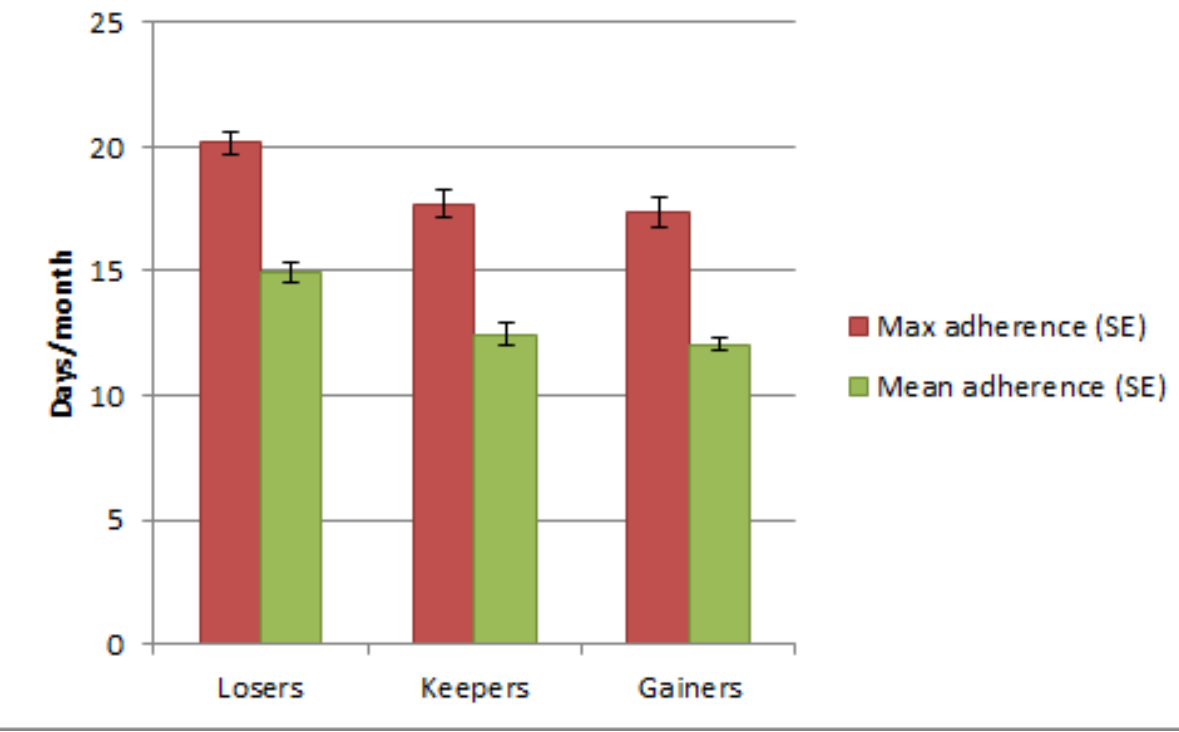
Adherence and Weight